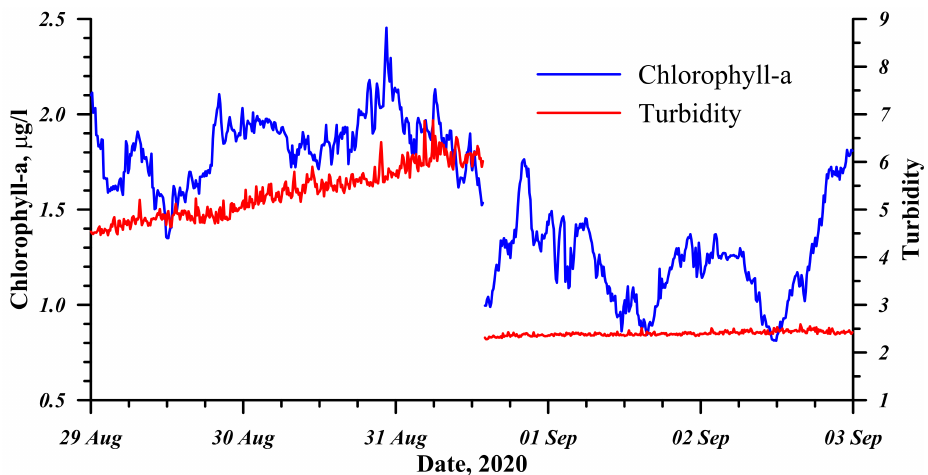
Figure 6. Process of biofouling of the sensors and the change in records after the